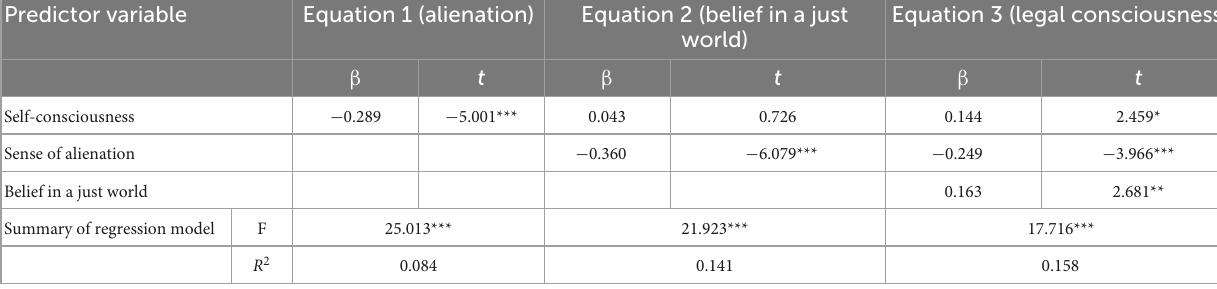
TABLE 6 Summary table of three regression analysis results.